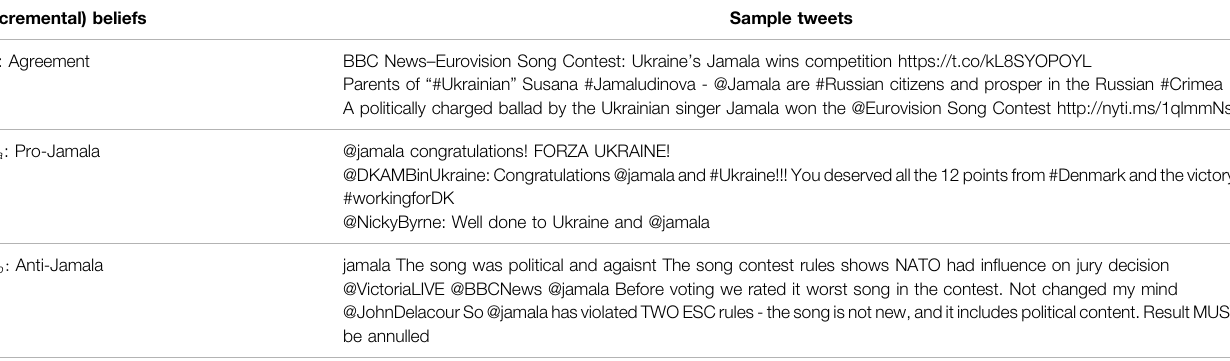
TABLE 5 | Top 3 tweets from separated beliefs (eurovision 2016).